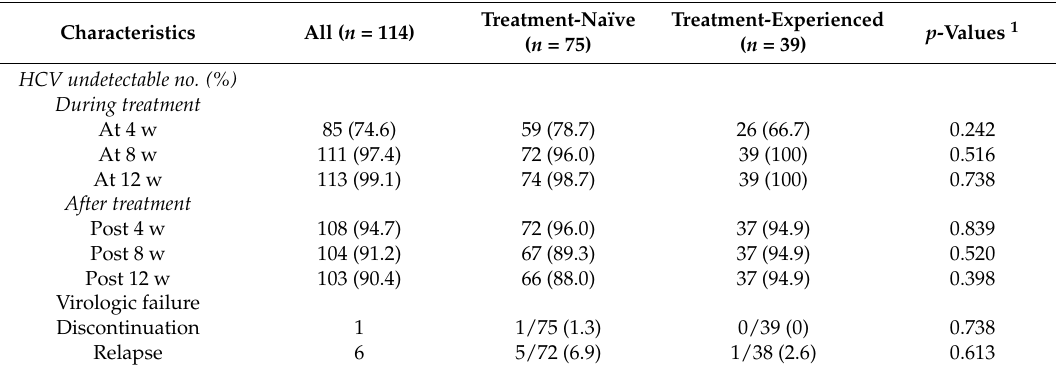
Table 2. Response during and after